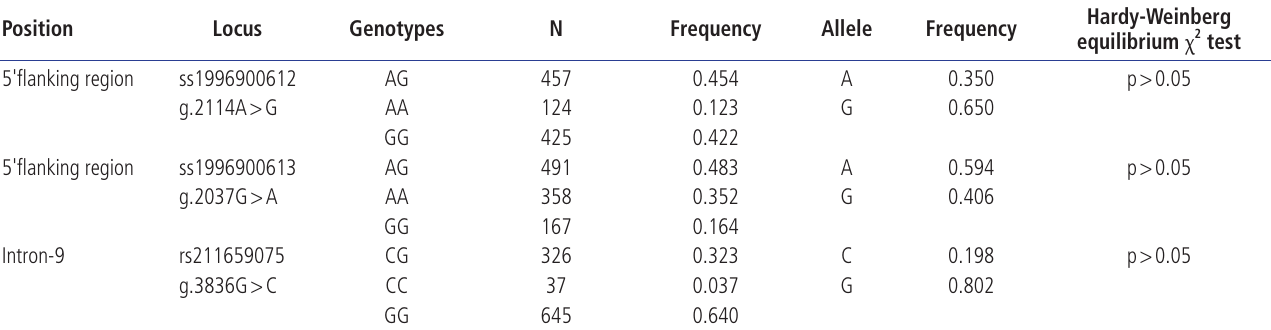
Table 2. Genotypic and allelic frequencies and Hardy-Weinberg equilibrium test of three single nucleotide polymorphisms of UDP-galactose-4-epimerase gene in Chinese Holstein cattle Position